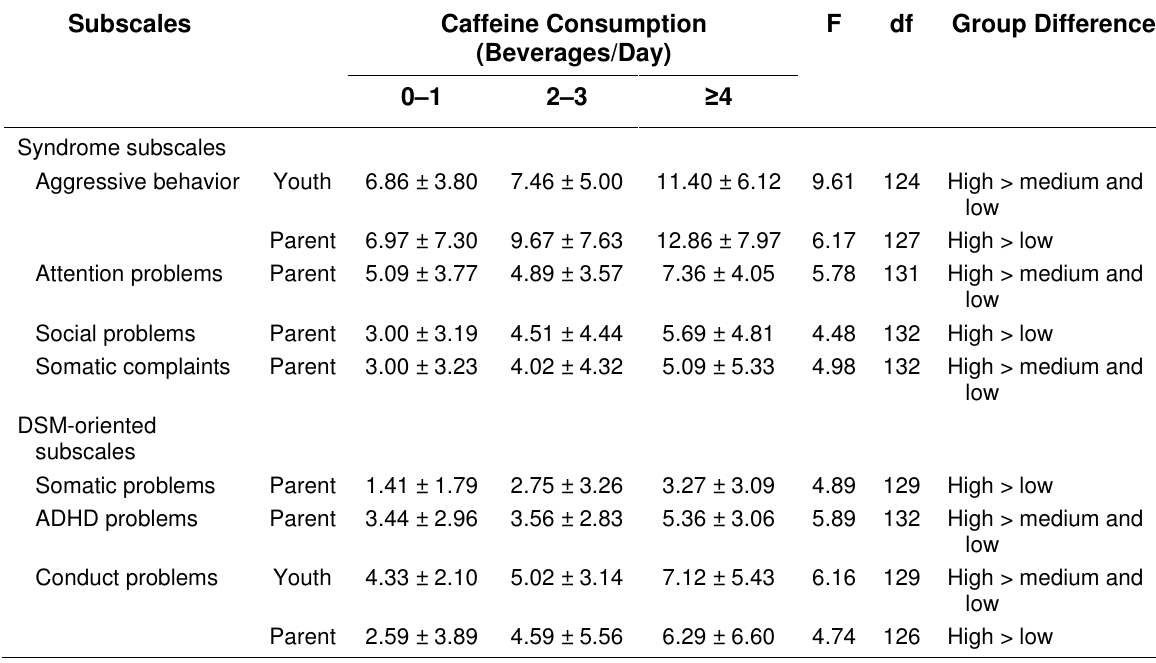
ANOVA-Tukey HSD Comparisons of Achenbach Scores Between Low, Medium, and High Caffeine Users ( p ≤≤≤≤